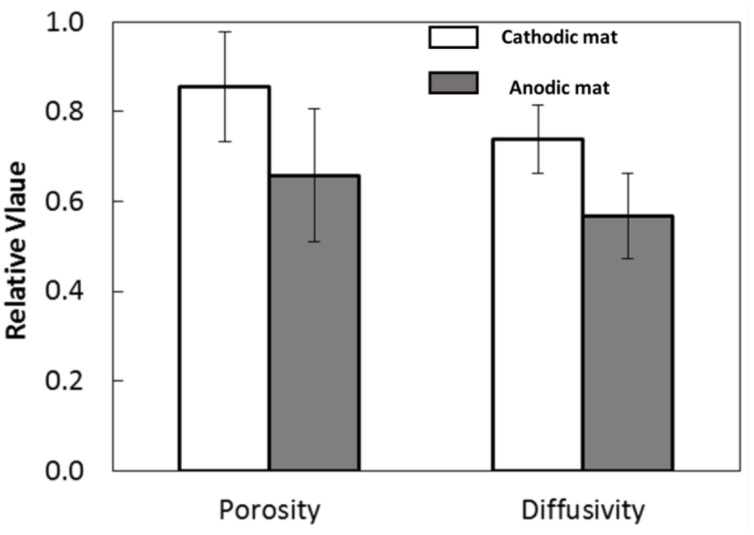
Porosity and diffusivity of the AN and CAT mats.